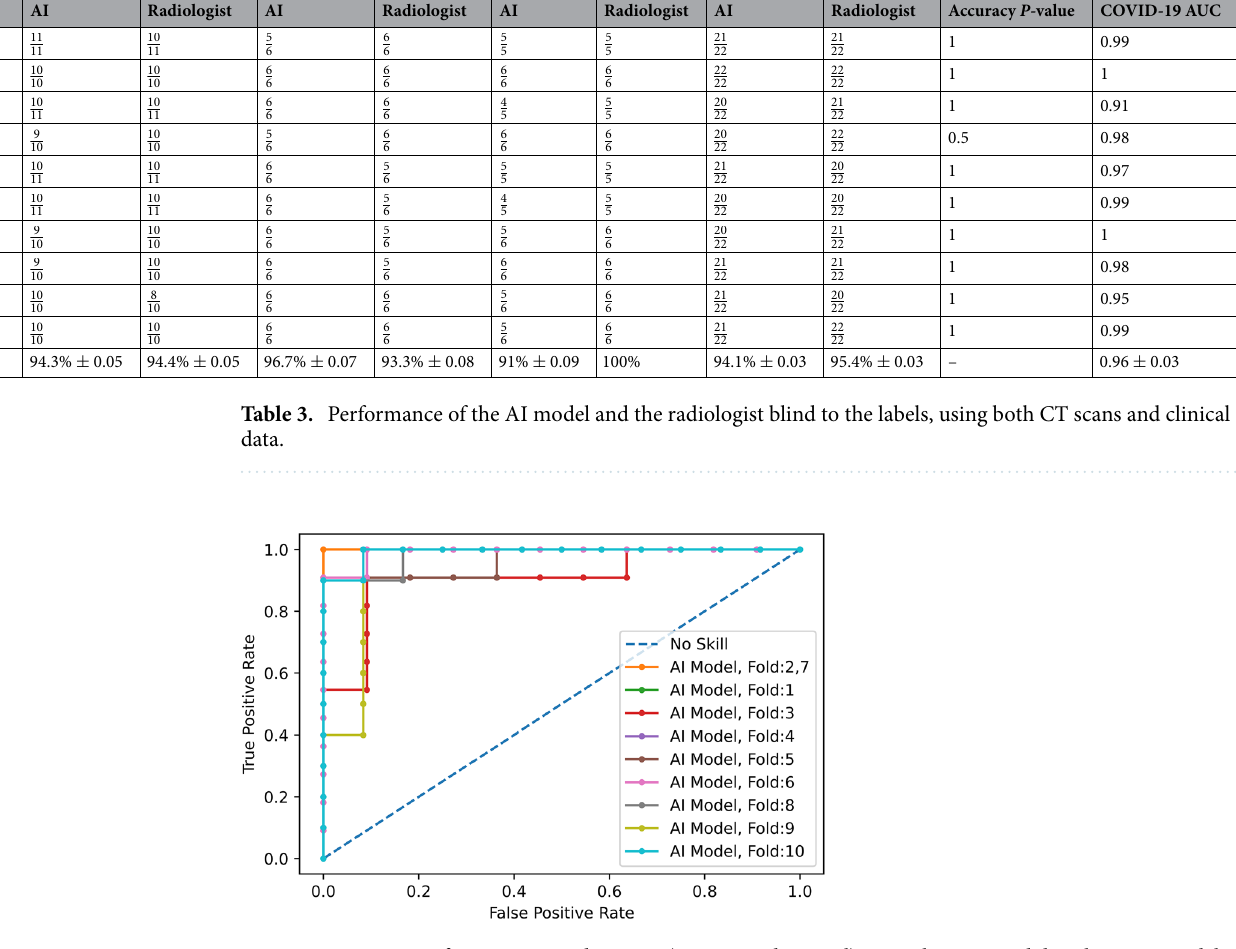
Figure 6. ROC curve for COVID-19 diagnosis (vs CAP and normal) using the proposed deep learning model and both CT scans and clinical